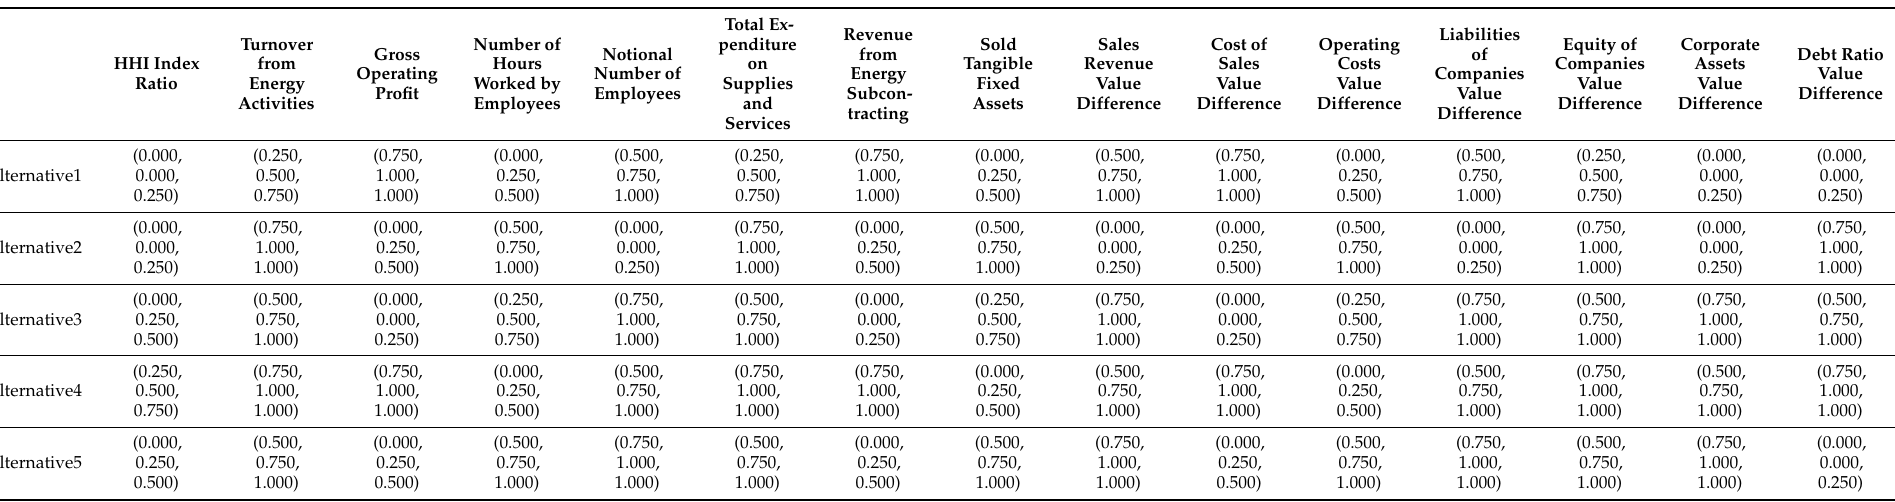
Table 3. Decision